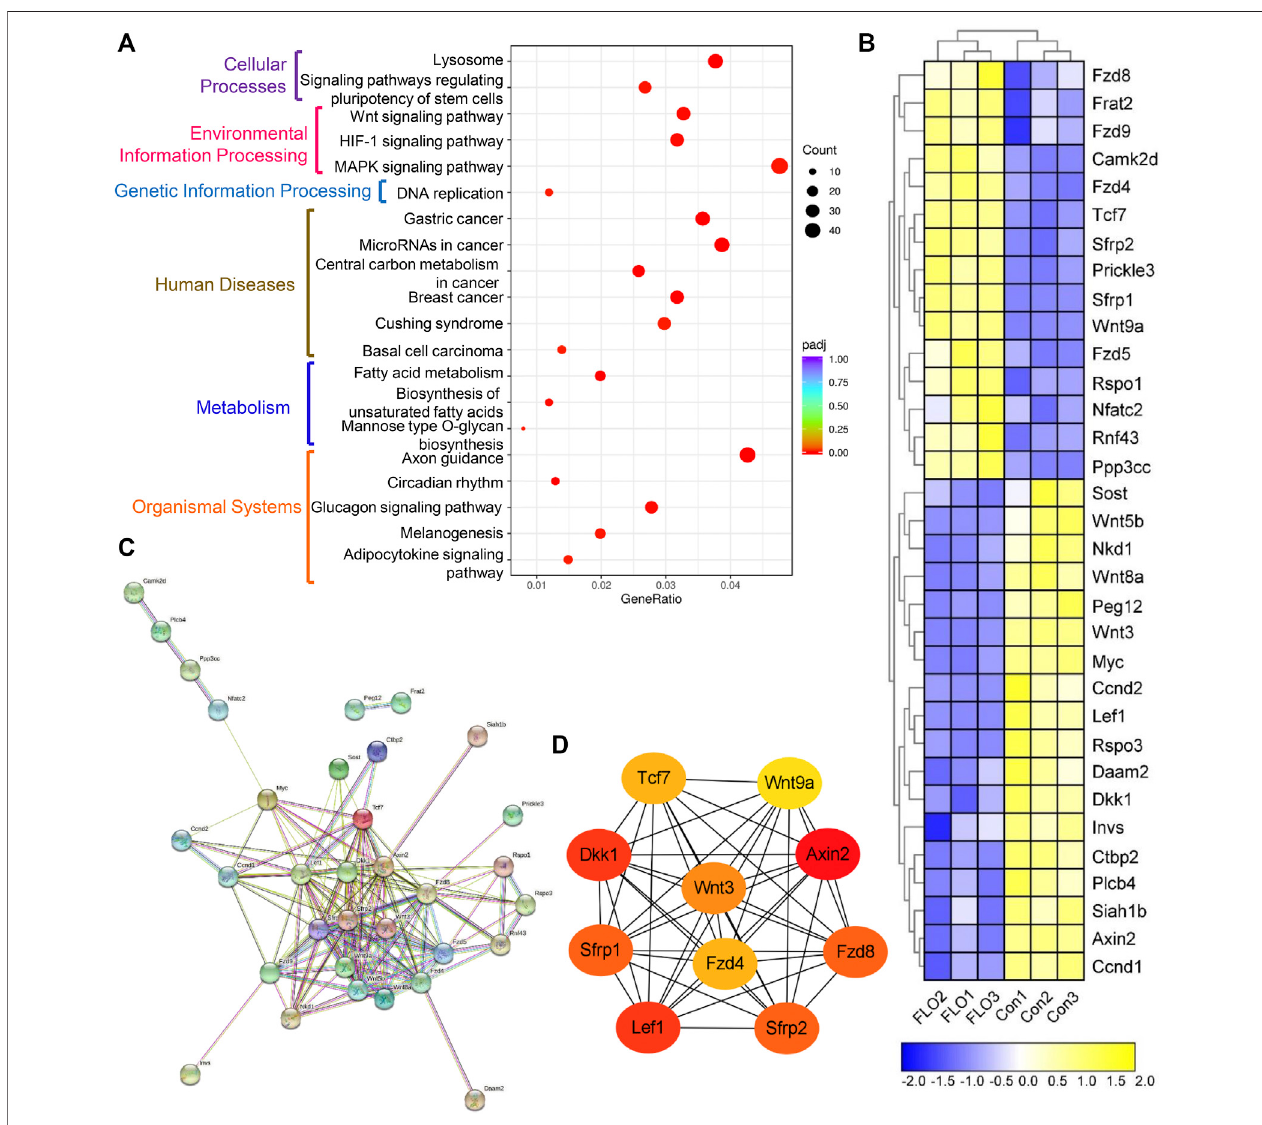
FIGURE 3 | KEGG pathway enrichment analysis of the integrated DEGs. (A) The top 20 of the 45 signi fi cantly enriched KEGG pathways clustered into six subcategories. GeneRatio indicates the ratioof enriched DEGs over total DEGs. Thesize and colorof the dot indicate thecount ofDEGs enriched in the KEGG pathway and the signi fi cance, respectively. (B) Heat map of the DEGs enriched in the Wnt pathway. Expression values of the six libraries are presented as the normalized FPKM values. Yellow colors indicate upregulated DEGs. Blue colors indicate downregulated DEGs. (C) PPI network analysis of the 33 DEGs based on the String database. (D) Top 10 hub genes in the network ranked by the degree method using cytoHubba.